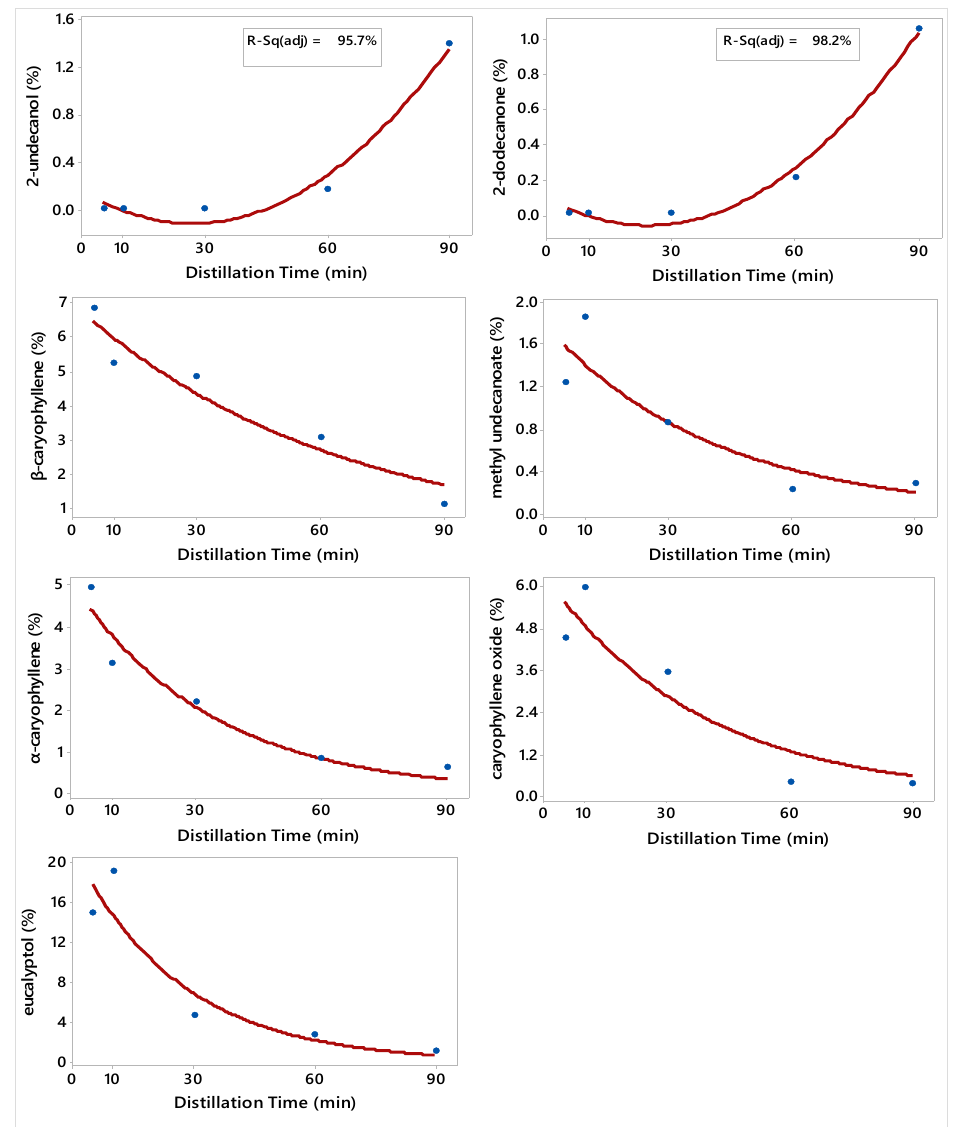
Figure 2. Plot of Distillation Time (DT) vs. the concentrations of six constituents of R. graveolens fruit along with the fitted second-order polynomial and Exponential regression models. Adjusted R 2 is given only for the second-order polynomial model, which is linear. The fitted models are: ˆ Y = 0.15 − 0.02 DT + 0.0004 DT 2 (2-undecanol), ˆ Y = 0.087 − 0.012 DT + 0.0003 DT 2 (2-dodecanone), ˆ Y = 6.97 Exp ( − 0.016 DT ) ( β -caryophyllene), ˆ Y = 1.79 Exp ( − 0.025 DT ) (methyl undecanoate), ˆ Y = 5.11 Exp ( − 0.03 DT ) ( α -caryophyllene), ˆ Y = 6.34 Exp ( − 0.026 DT ) (caryophyllene oxide), and ˆ Y